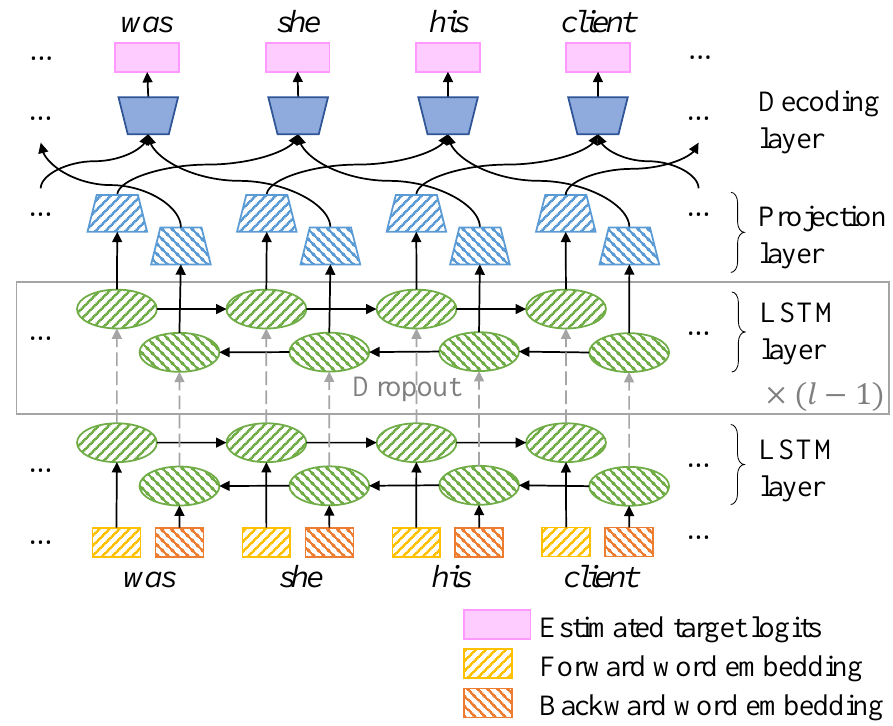
Figure 1. Bidirectional word RNN (modified from Figure 1 in